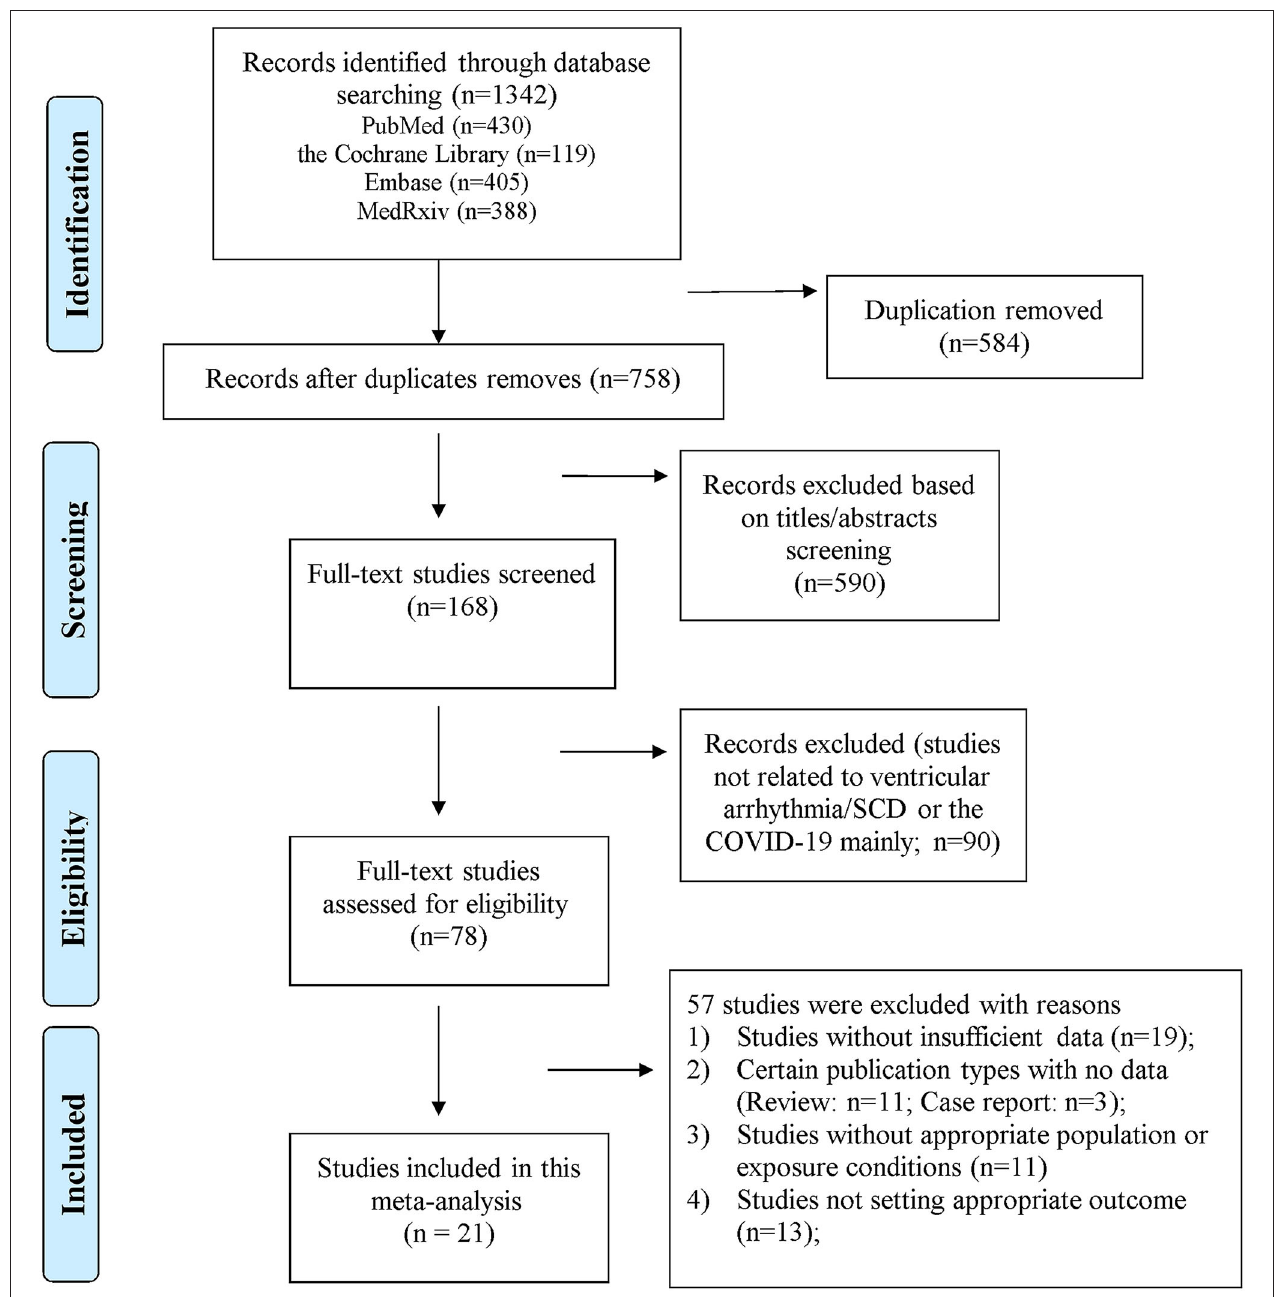
FIGURE 1 | Flow chart of study